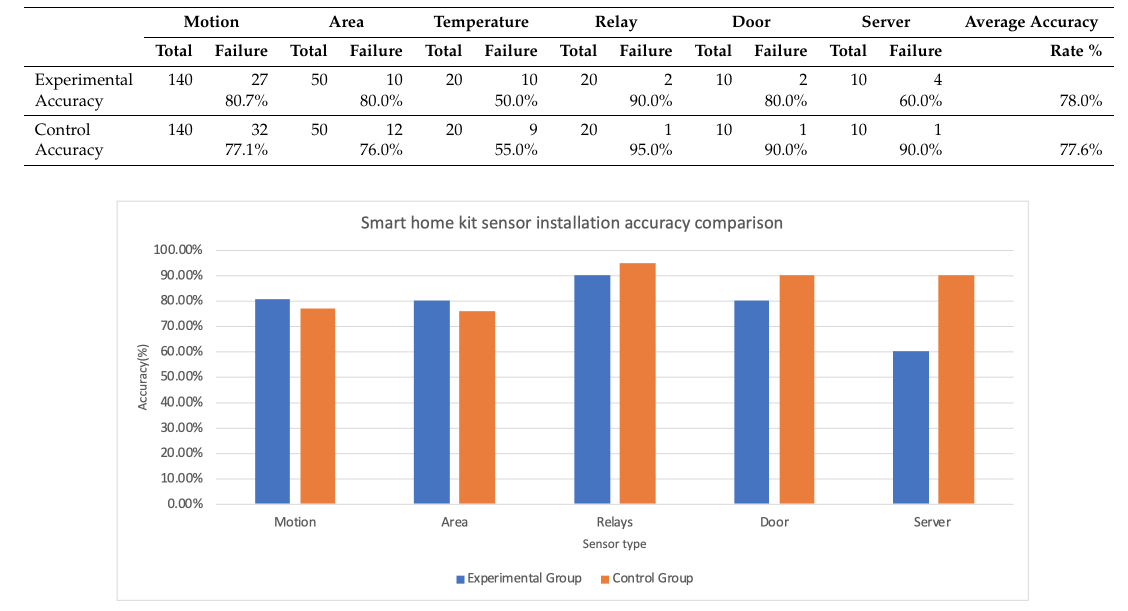
Table 2. Results of real installation.